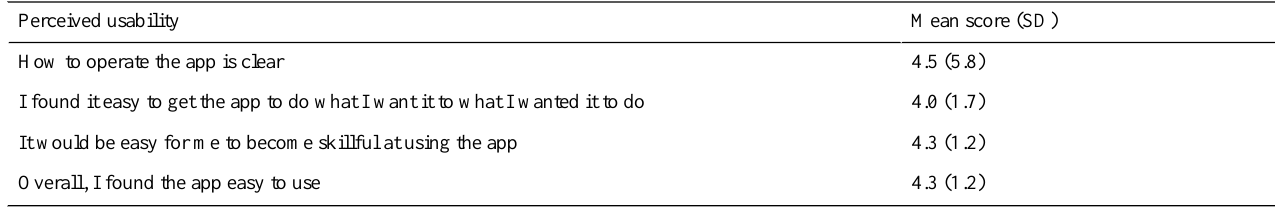
Table 6. Perceived usability of the app on a Likert scale ranging from 1 to 5 (higher scores indicate stronger